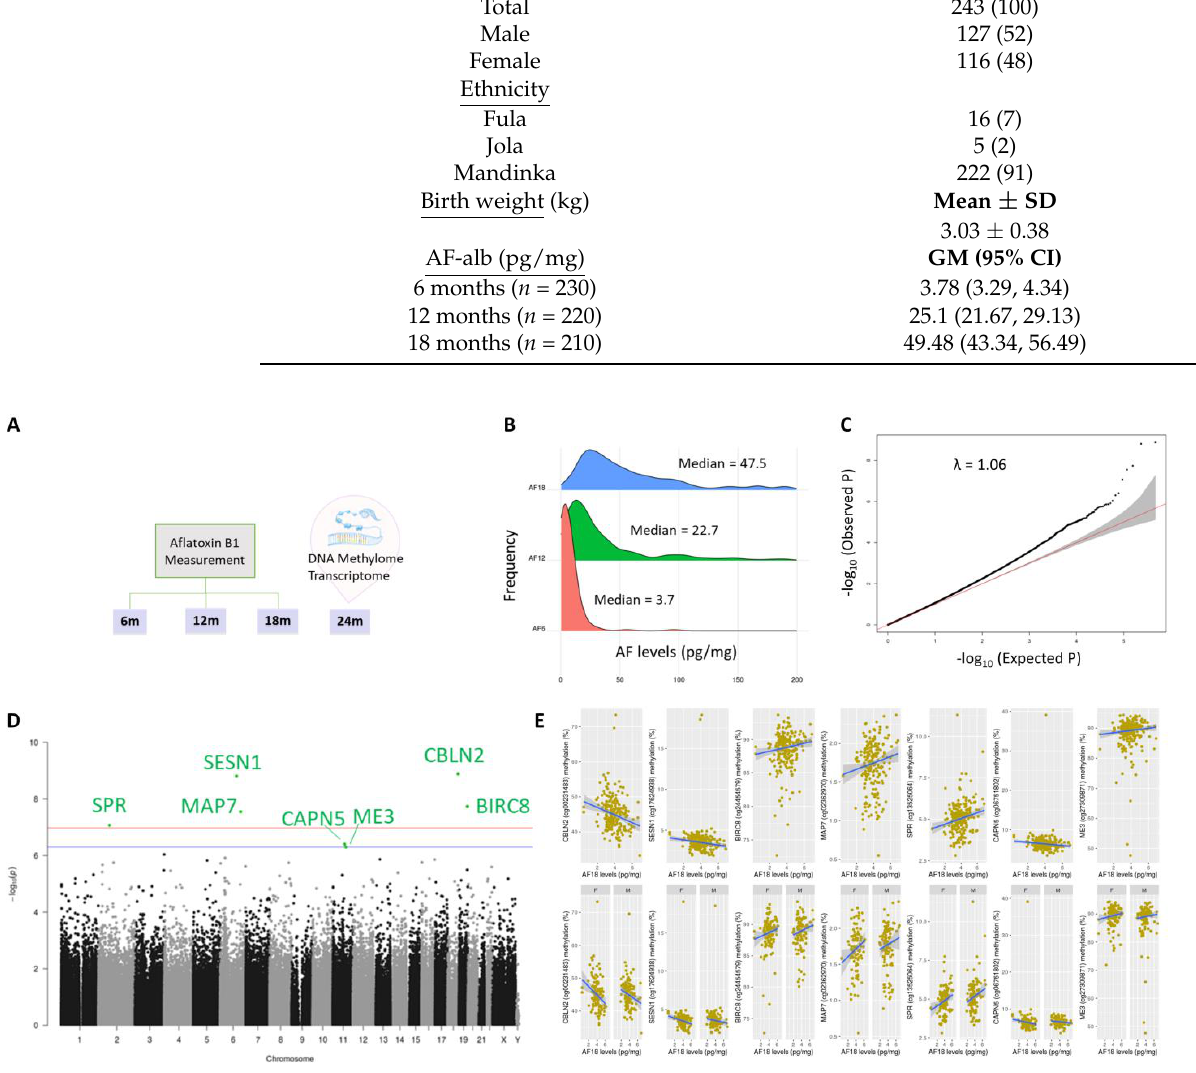
Figure 1. ( A ) Study design of the project. Aflatoxin-albumin adducts were measured in the infants at 6, 12 and 18 months old. The DNA methylome and transcriptome were profiled in infants’ blood, collected at 24 months. ( B ) Aflatoxin B1 levels at 6, 12 and 18 months during infancy. ( C ) Q-Q plot and the genomic inflation factor (lambda) of the DMP analysis, based on the adjusted model using AF18. ( D ) Manhattan plot showing the significant DMPs, being above the Bonferroni (red) and FDR (blue) lines. ( E ) Scatter plots of methylation vs. AF18 levels for the DMPs, stratified in the second row by child sex.